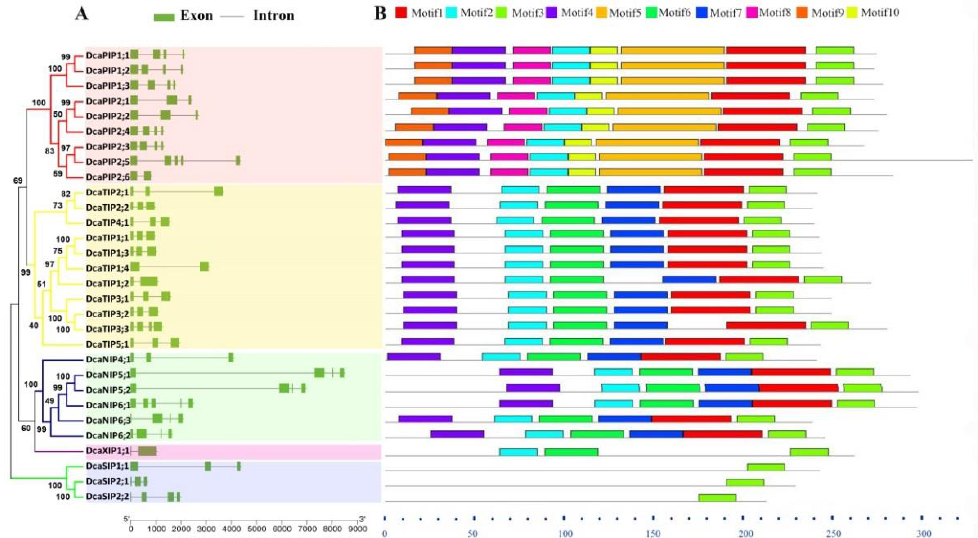
Figure 2. Exon/intron structure ( A ) and motif organization ( B ) of the DcaAQP genes. Multiple alignments were conducted by Clustal W and phylogenetic tree was generated by MEGA 6.0 using Maximum Likelihood (ML) method with 1000 bootstrap replicates. Relative protein or gene lengths can be estimated by gray bars. Exons and introns are represented by green boxes and gray lines, respectively. Information of motifs was provided in Figure S2.